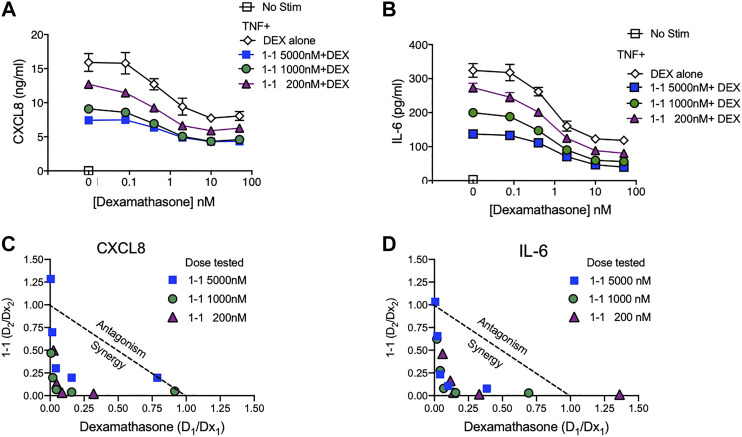
Synergistic suppression of CXCL8 and IL-6 production by compound 1–1 and DEX. Levels of CXCL8; (A) and IL-6; (B) secreted into the supernatant by RA FLS stimulated overnight with 1 ng/ml of TNF and treated with the indicated concentrations of 1–1 and DEX were measured by ELISA. Data are represented as mean ± SEM. Potency ratios were calculated and presented as isobolograms for CXCL8; (C) and IL-6; (D). The dotted line represents additivity between DEX and the compounds. Data are representative of two independent experiments showing similar results.